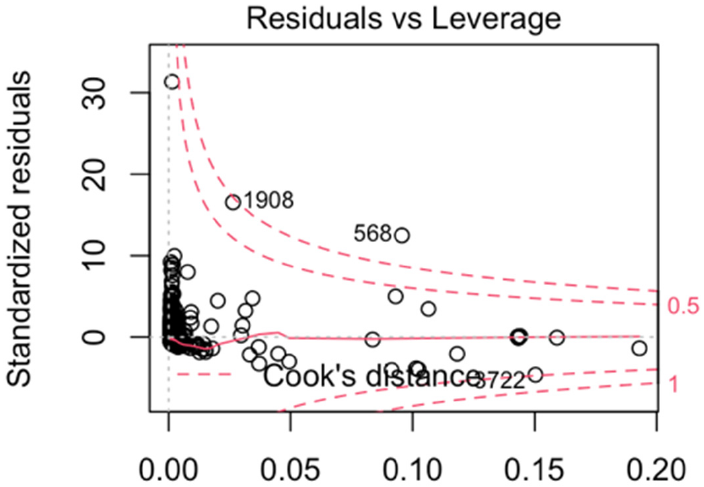
Figure 4. Residuals versus fitted value plot.